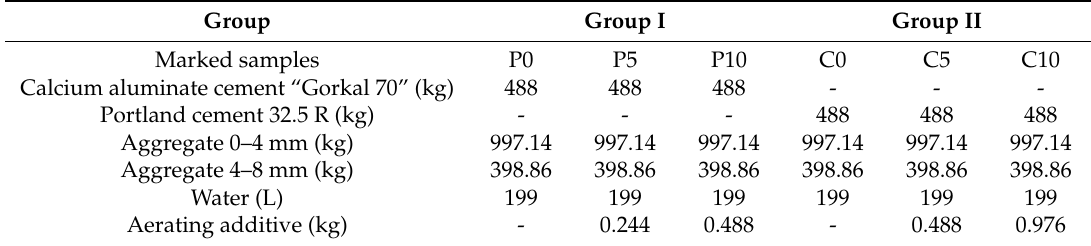
Table 1. The comparison of prepared concrete mixes in 1 m 3 of concrete